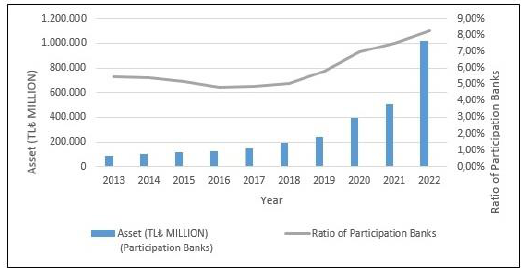
Figure 2. Development of Participation